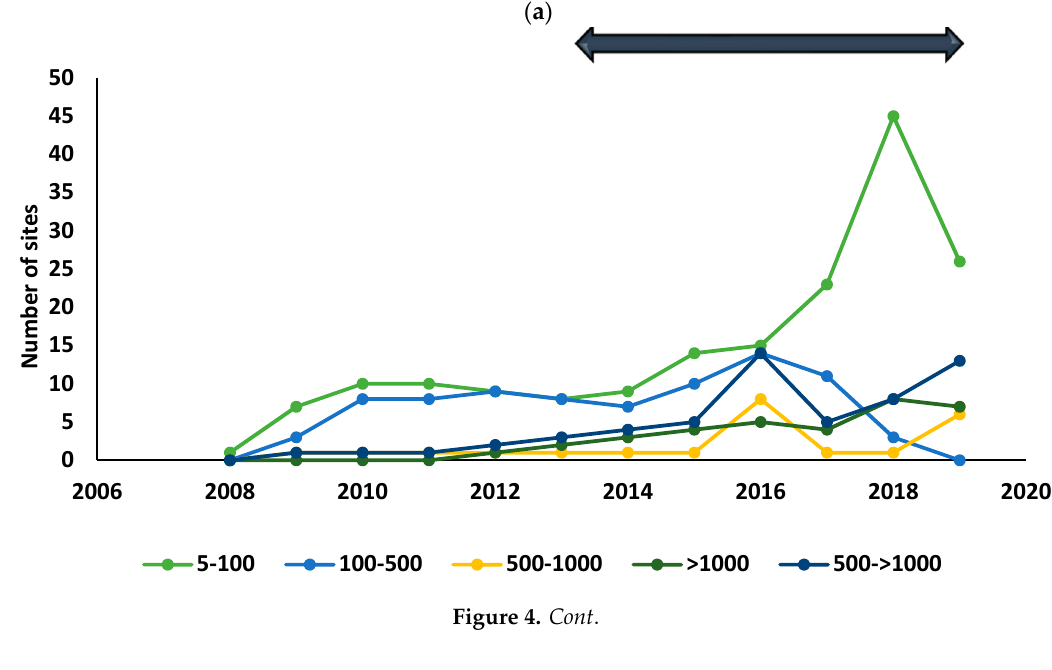
Figure 4. The extent of Sagittaria platyphylla infestations in South Africa from 2008 to 2019, categorised as the total number of sites with a particular population size category ( a ) and plant density ( b ) recorded each year. The black arrow across the top indicates the initiation of management options, including mechanical and chemical control.